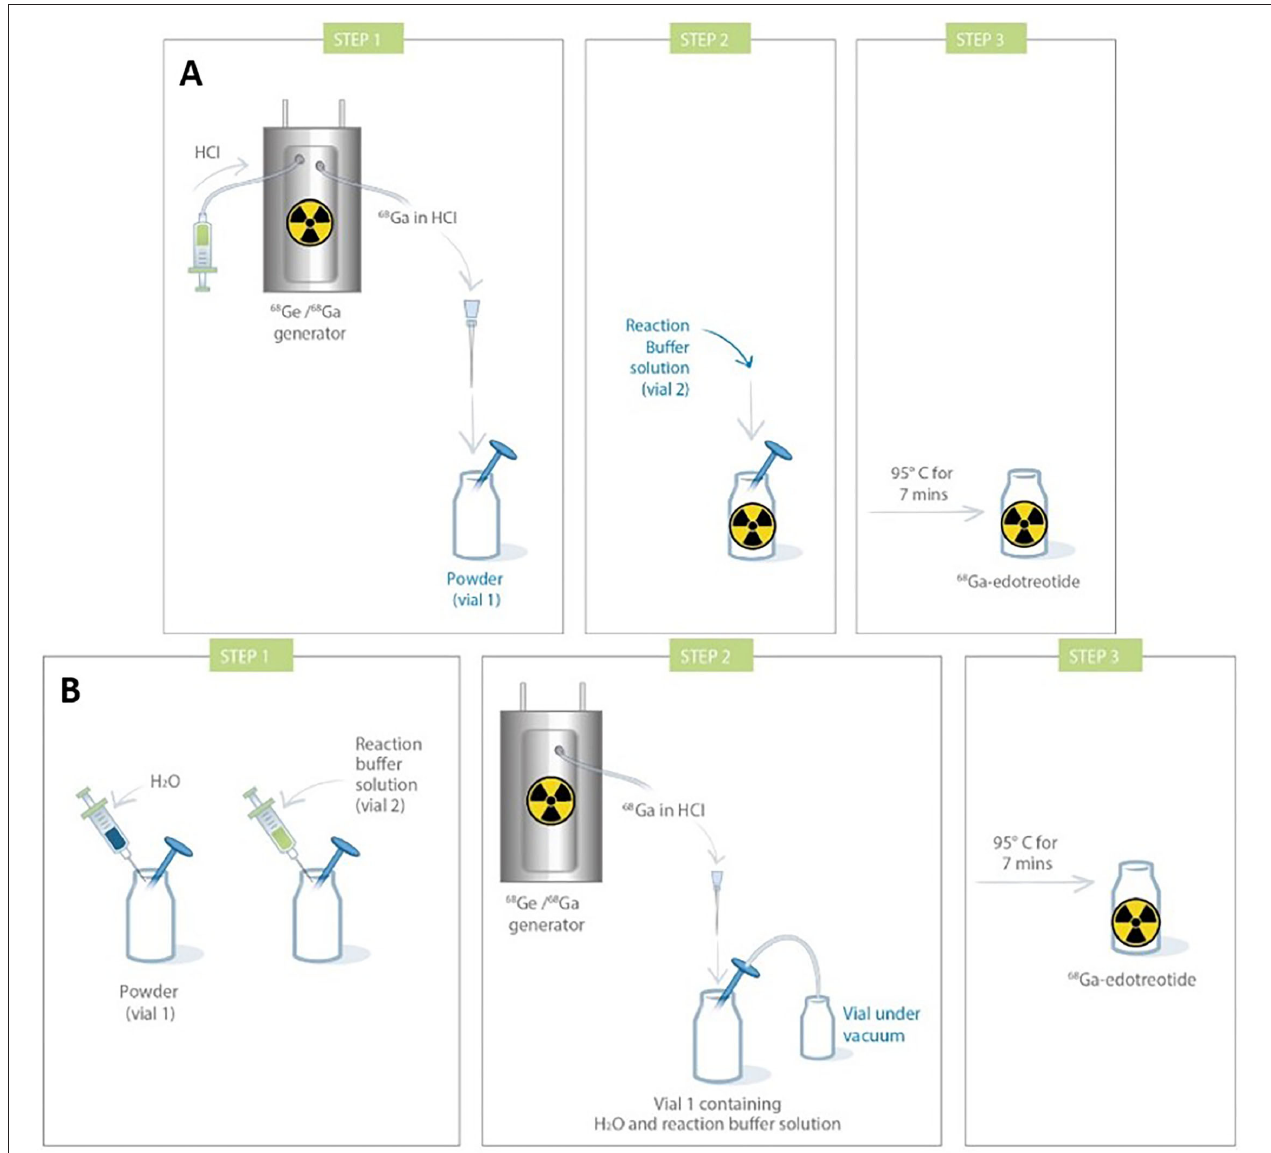
FIGURE 5 | Comparison of procedures for Somakit TOC ® labeling with 2 different commercial generators [ (A) . Galliapharm (Eckert & Ziegler) GalliAd (IRE Elit); (B) . GalliAd ® and IRE Elit)